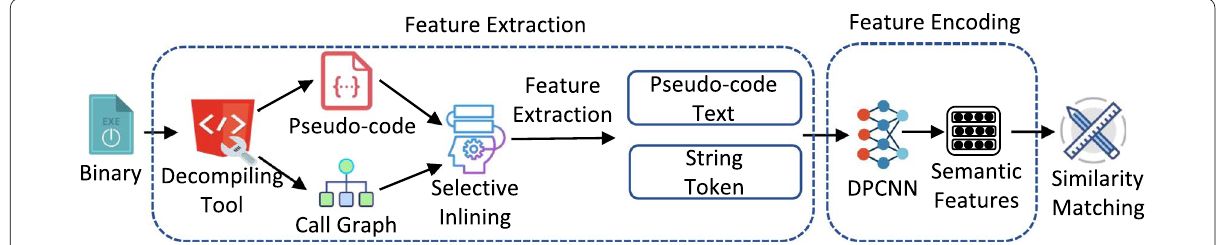
Fig. 3 An overview of our